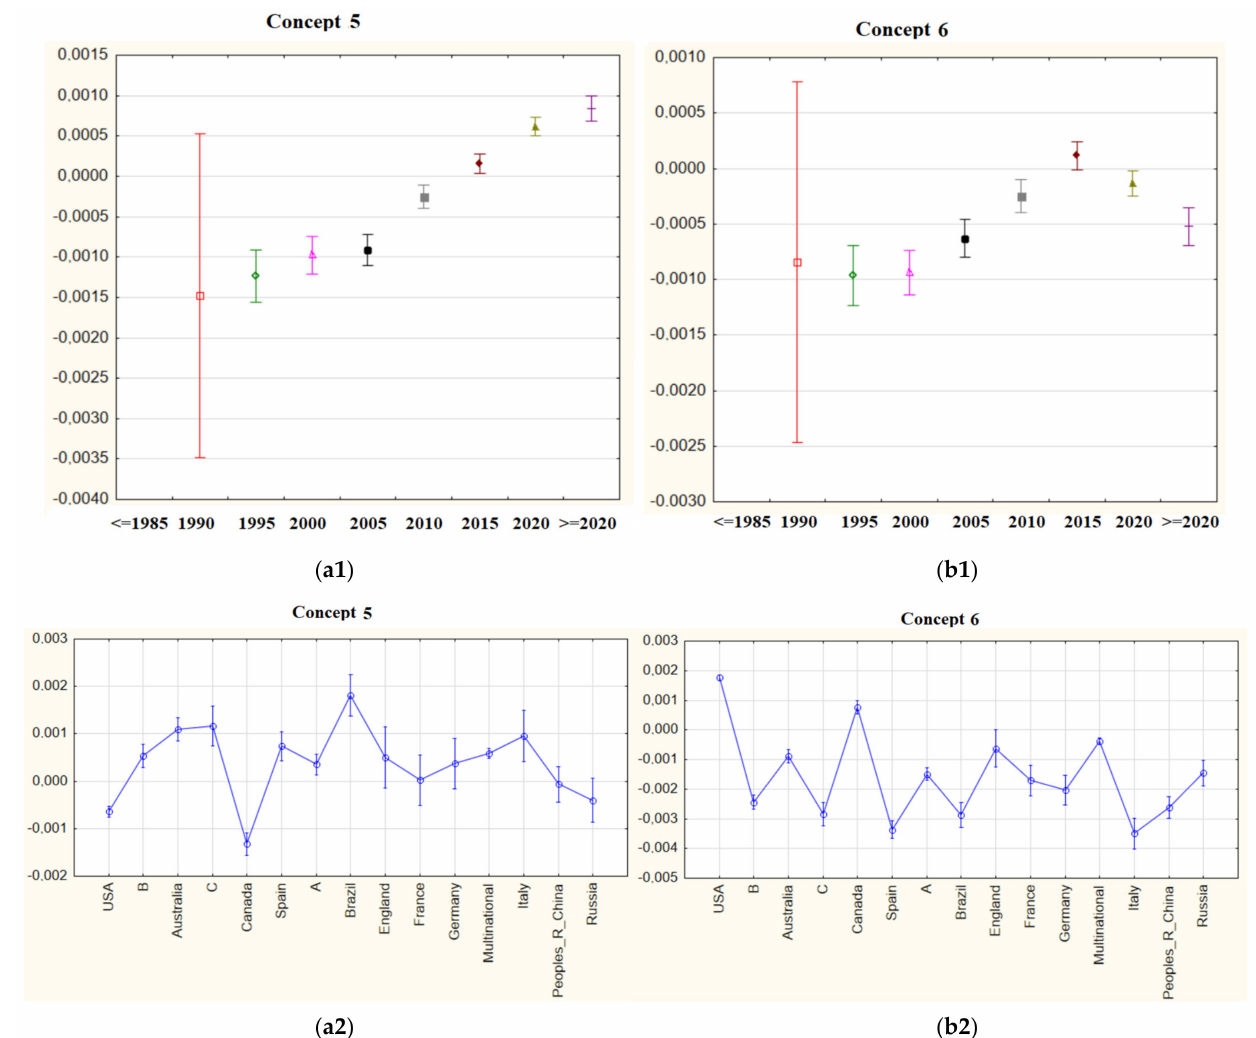
Figure 17. ( a1 ) mean importance weights of Concept 5 for five-year periods; ( b1 ) mean importance weights of Concept 6 for five-year periods; ( a2 ) mean importance weights of Concept 5 via countries; ( b2 ) mean importance weights of Concept 6 via